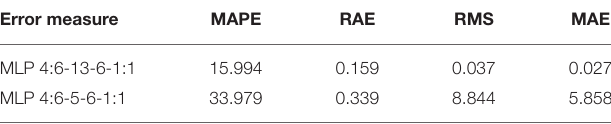
TABLE 3 | Measures prediction ex-post of analyzed neural